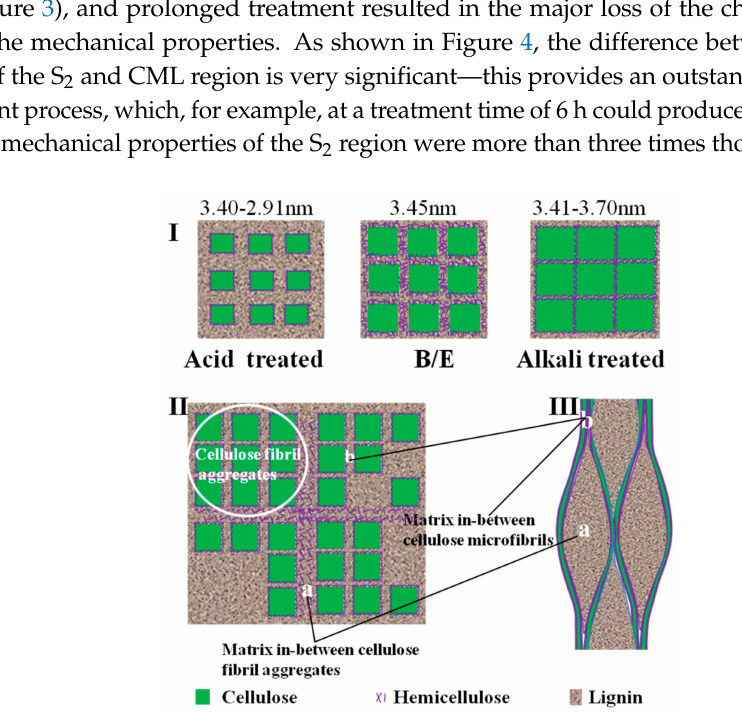
Figure 6. Schematic illustration of changes in cellulose fibril aggregates before and after delignification treatment (( I ): Changes in cellulose crystal size; ( II ): Original cellulose fibril aggregates cross section; ( III ): Cellulose fibril aggregates longitudinal